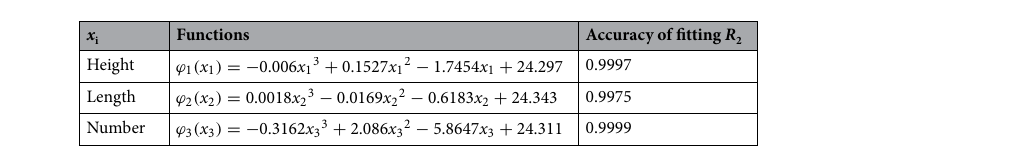
Table 2. The functions of the system characteristics.